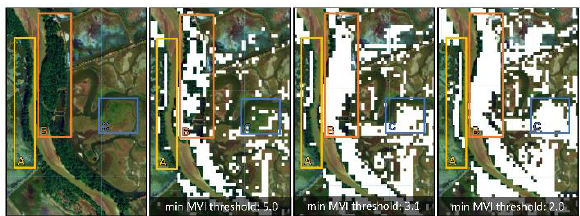
Figure 14 . Varying thresholds in a complex environment for mangroves in regions A (yellow) and B (orange), and moss in region C (blue). The white pixels are those identified to be mangroves for the case MVI ≥ 5.0 (middle left), MVI ≥ 3.1 (middle right), and MVI ≥ 2.0